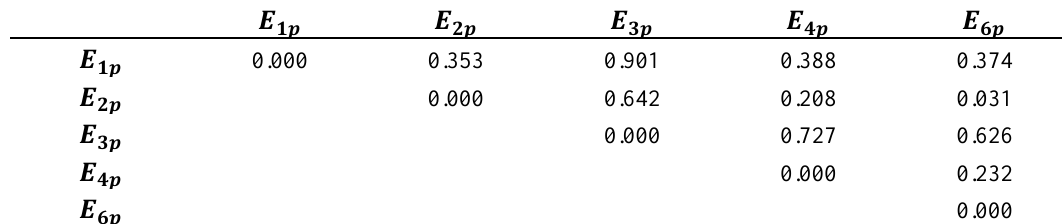
Figure 5. The spectra of the endmember set for the synthetic hyperspectral image. ( a ) After the first step; ( b ) After the second step; ( c ) After the final steps. Table 2. SA values of endmember set after the second processing step. The values shown in bold italics are those less than the threshold